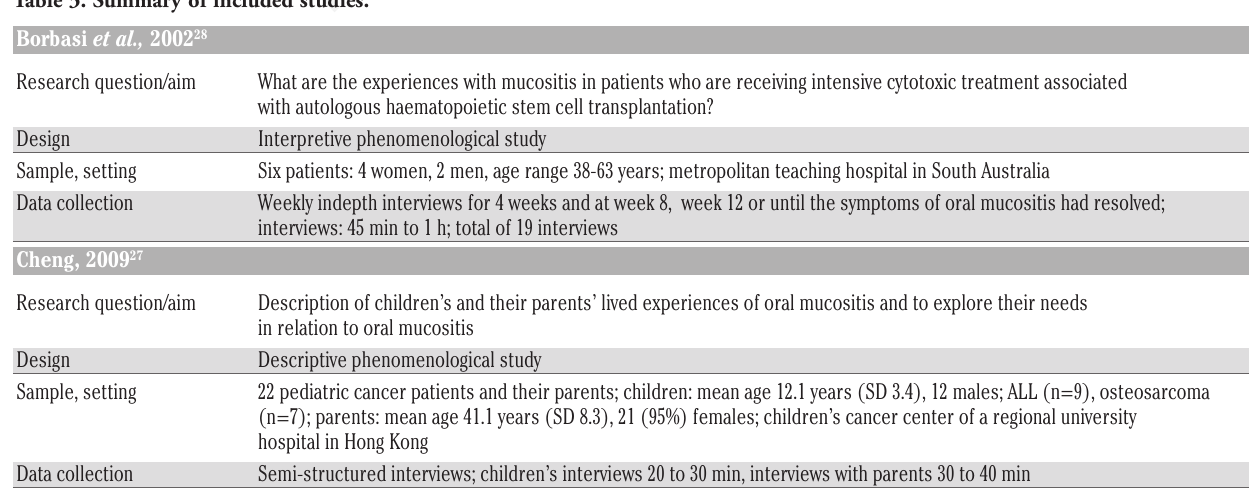
Table 3. Summary of included studies.